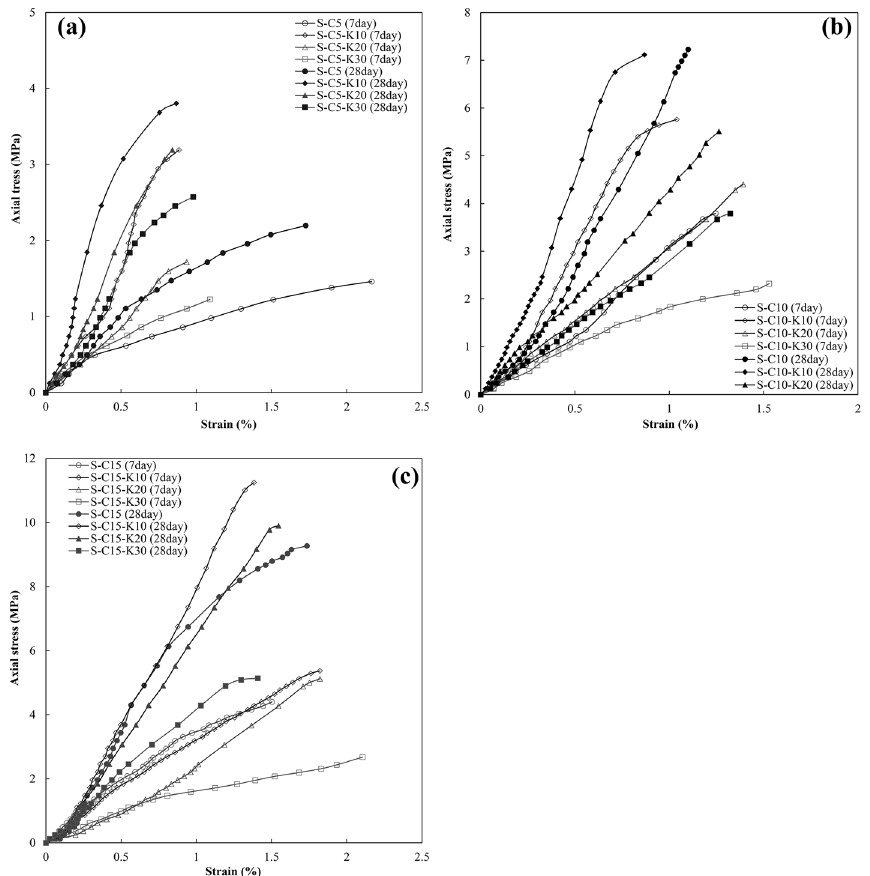
Fig. 14 The stress–strain curve for CSG mixtures containing kaolinite additive and cured at both ages of 7 and 28 days: a the family of mixtures with 5% cement, b the family of mixtures with 10% cement, a the family of mixtures with 15%